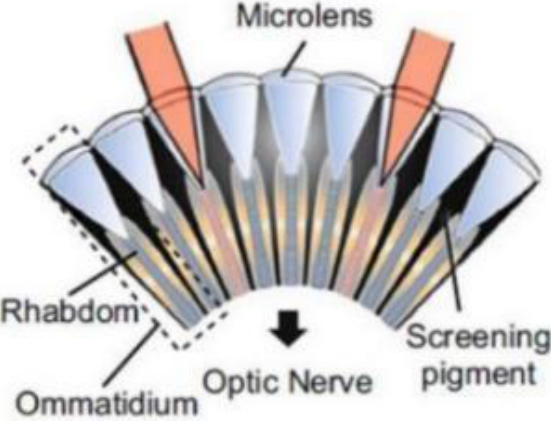
Figure 5. The schematic of an apposition compound eye.